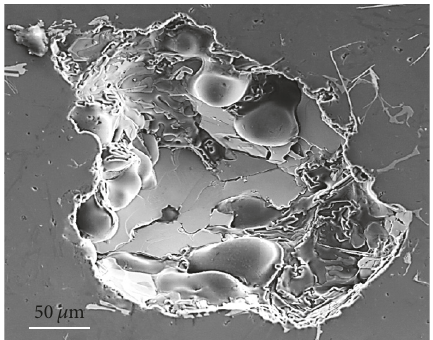
Figure 18: Secondary electron image of La-rich platelet within a pore in Sr-modified, high (1.025%) La-containing A356 alloy (sample SDAS ∼ 42 𝜇